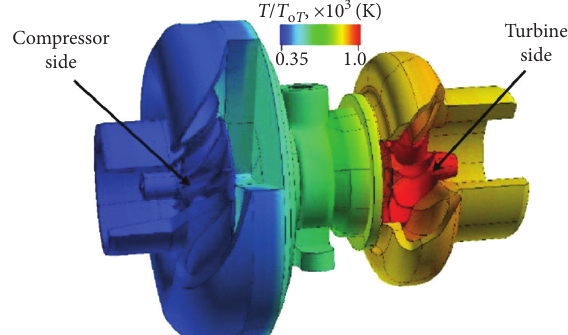
Figure 14: Rotor temperature distribution of Bohn [19].